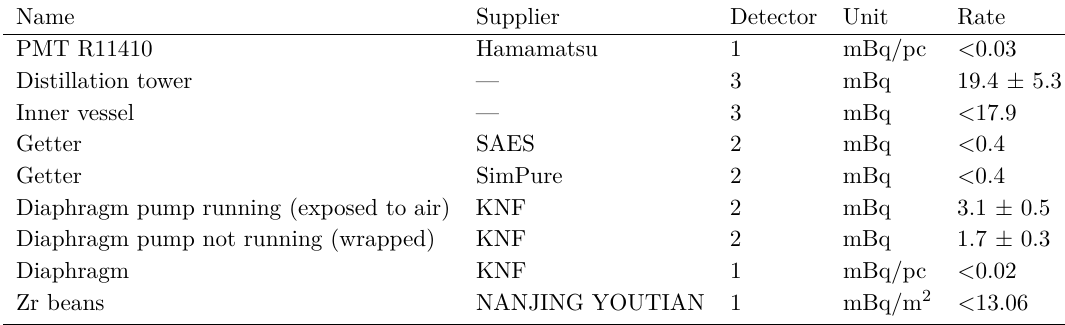
Table 6. Radon emanation measurement results (upper limit with 90% C.L. is given). The serial number of detector corresponds to table 5. All the measurement are performed at room temperature.